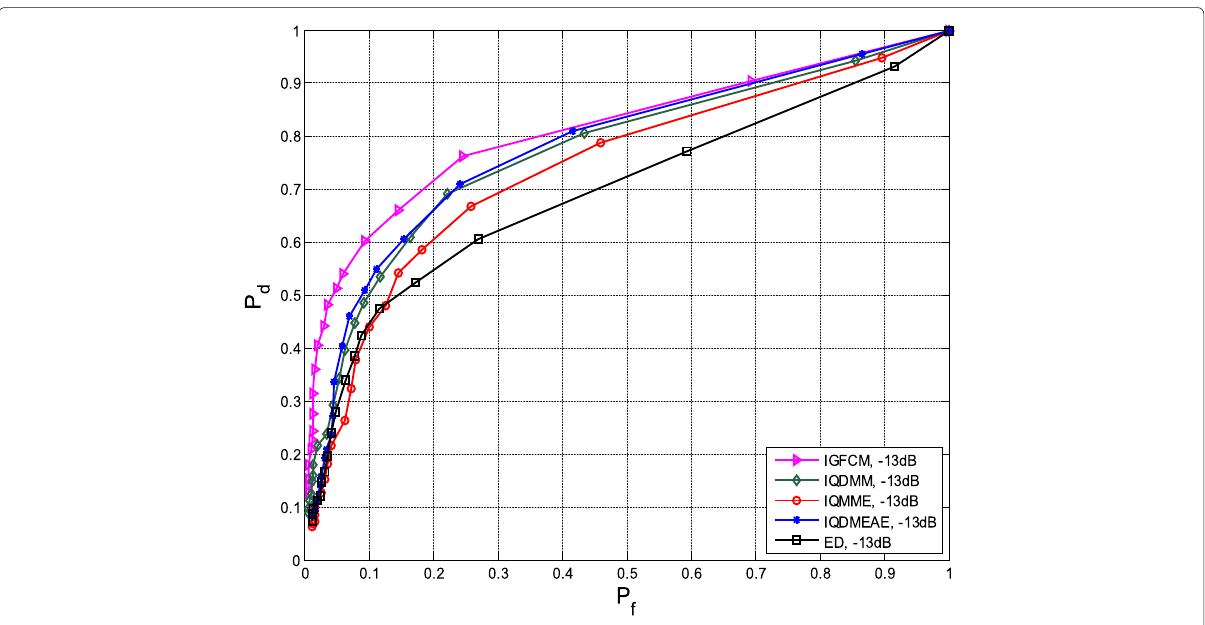
Fig. 6 ROC curves for different algorithms at SNR = − 13 dB and M = 2